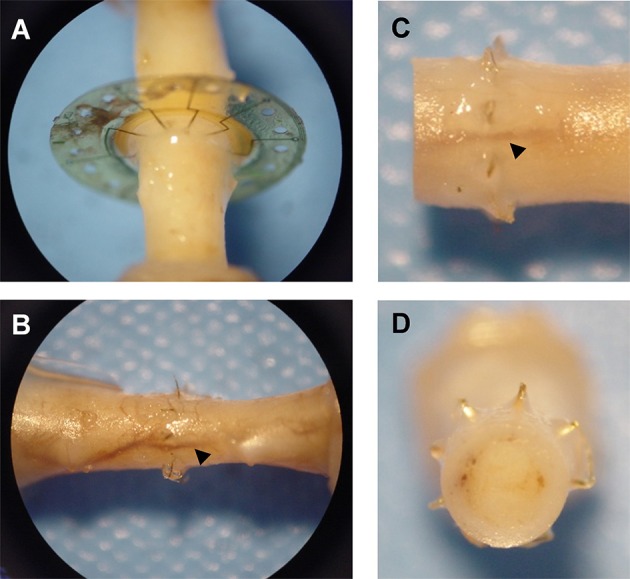
Integration of macro-sieve electrodes into regenerated nerve tissue. Photos of regenerated nerve fibers crossing MSEs (A) Micro-vasculature (arrowheads) crossing implanted MSE (B–D).